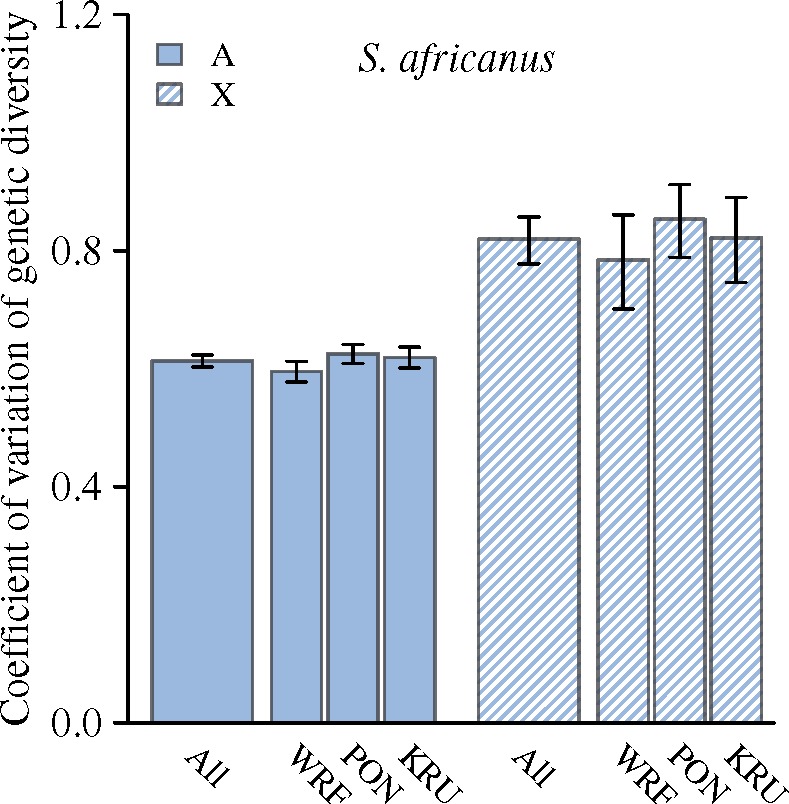
Comparison of the coefficient of variation (CV) of genetic diversity among scaffolds assigned to the X chromosomes and autosomes. Only in Stegodyphus africanus, was genetic diversity sufficiently large to allow this comparison. WRF, PON and KRU represent the three sampled S. africanus populations, while ALL is the average per species. CVs were estimated as SD/average. Error bars represent 95% confidence limits obtained by bootstrapping.